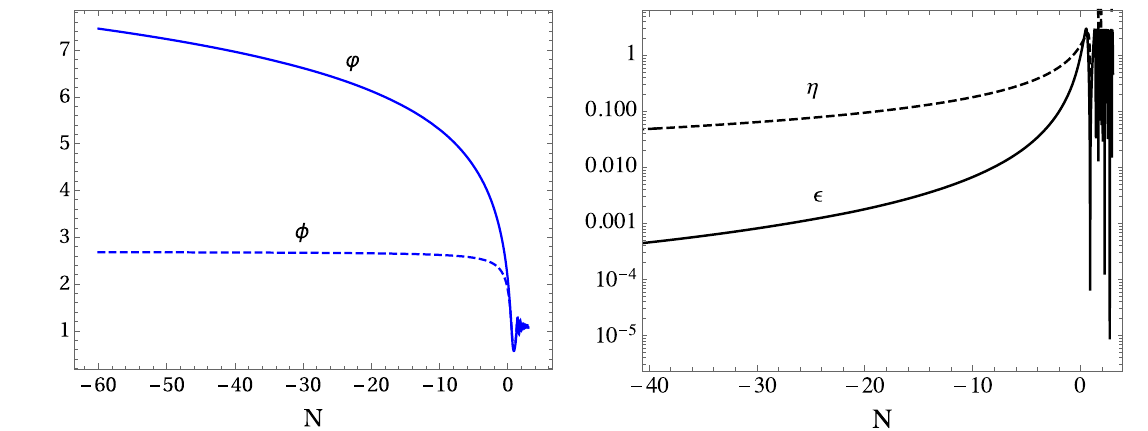
Fig. 2 In the left panel we depict the evolution of the scalar field (in the units of m P ) during inflation versus the e-folding number. The solid blue line indicates the evolution of the canonically normalized field ϕ ,